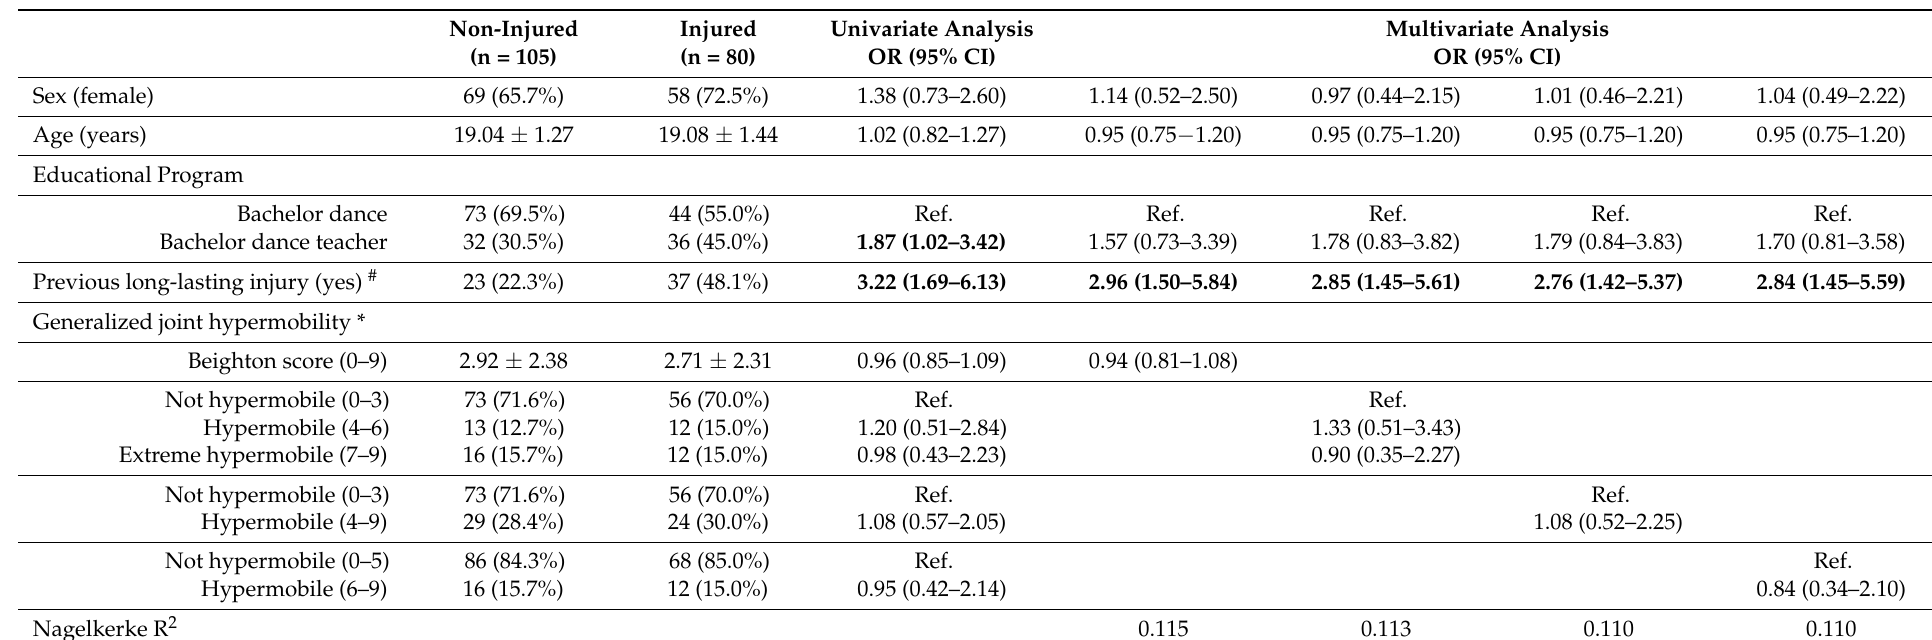
Table 3. Univariate and multivariate models of potential risk factors for substantial